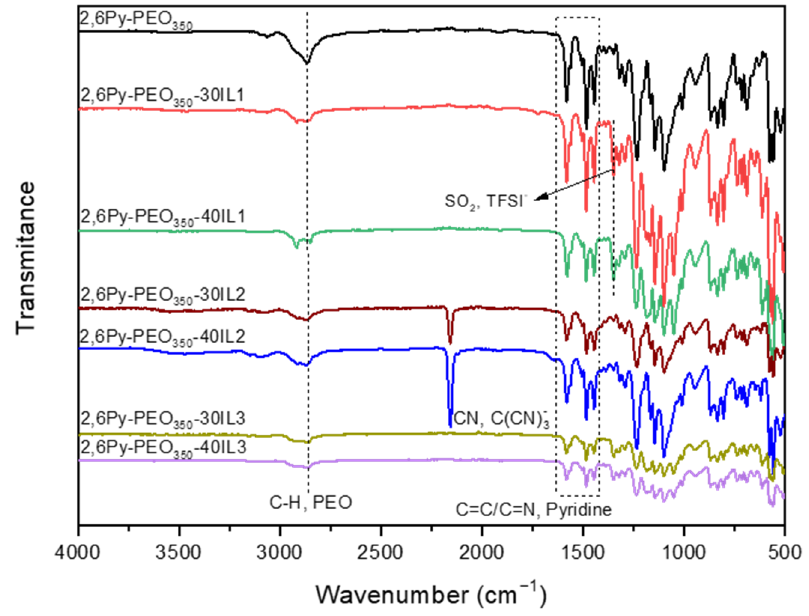
Figure 2. ATR-FTIR spectra of the precursor polymer and the polymer-IL composite membranes.